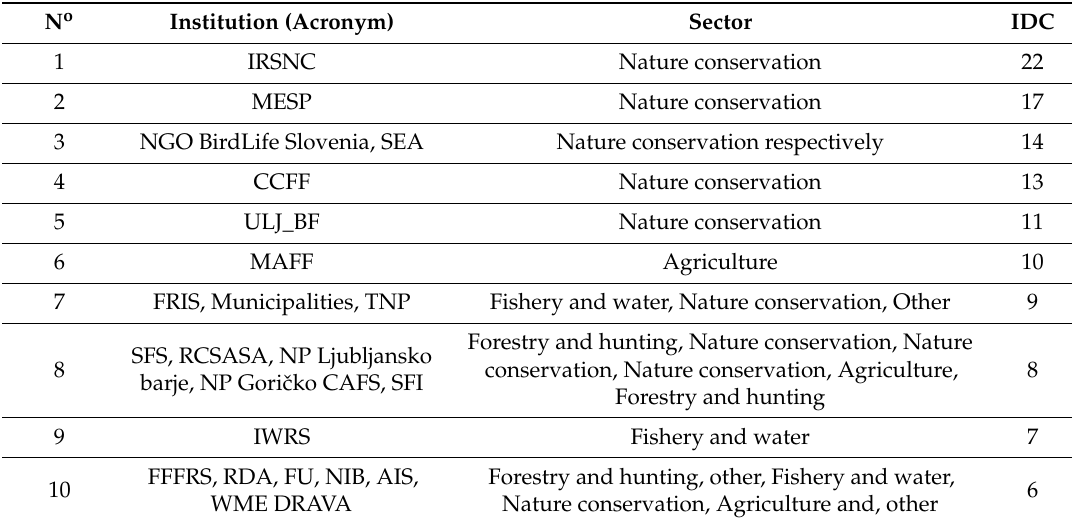
Table A3. Top 10 indegree centrality values (IDC) for institutions in directed network of cooperation.